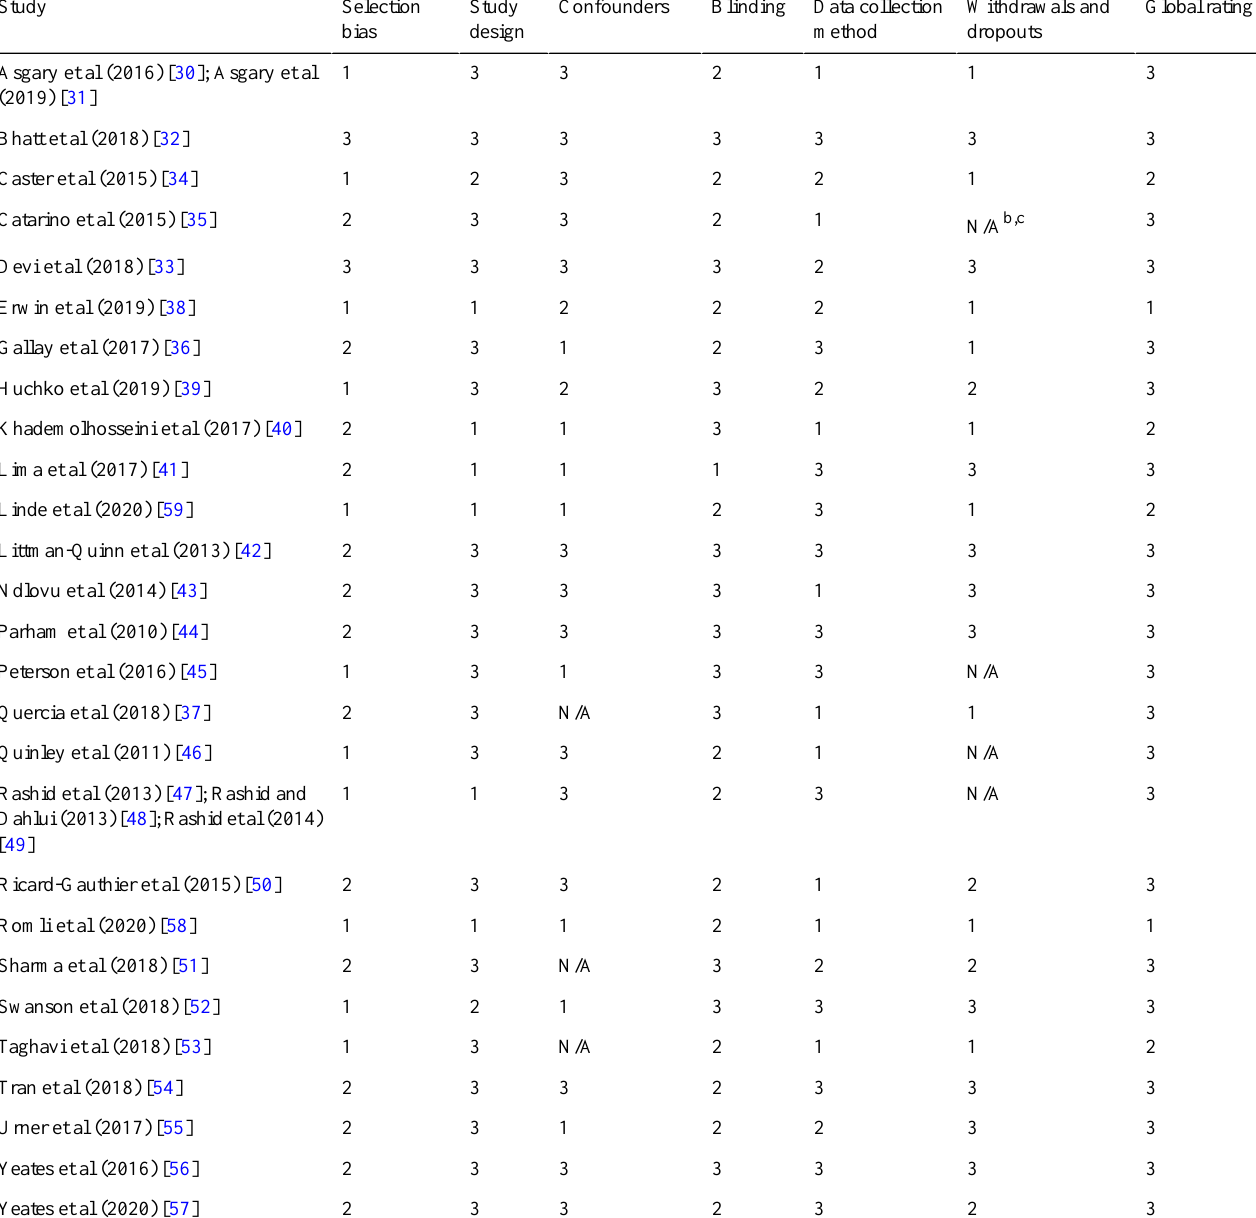
Table 1. Risk of bias assessment for included studies using the Effective Public Health Practice Project’s quality assessment tool for quantitative studies a